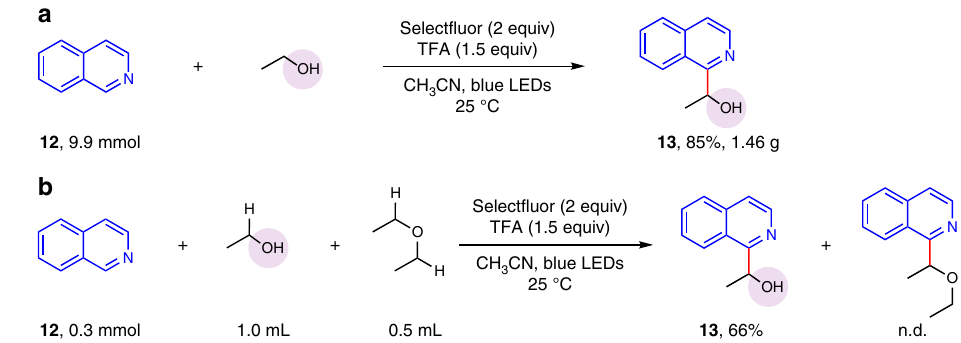
Fig. 6 Investigation and application of this protocol. a Gram-scale synthesis experiment. b Intermolecular competition experiment